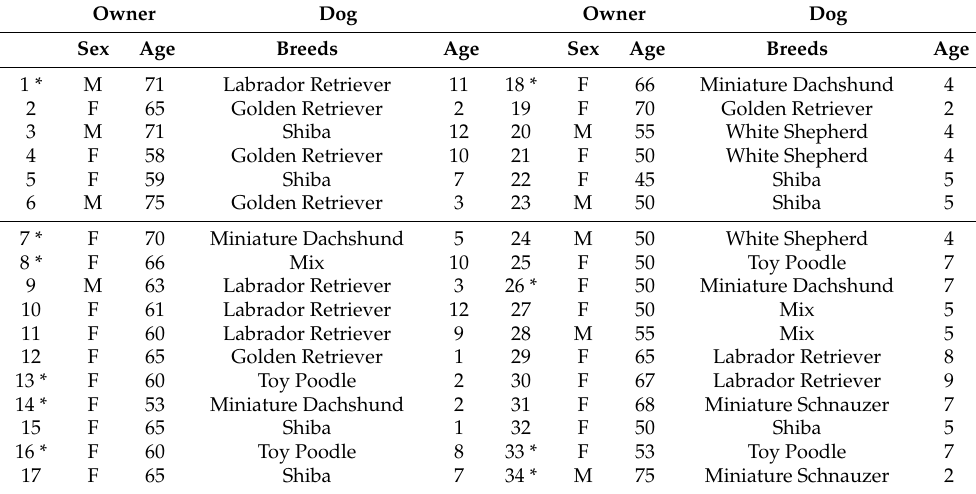
Table 1. List of participants in the experiments.